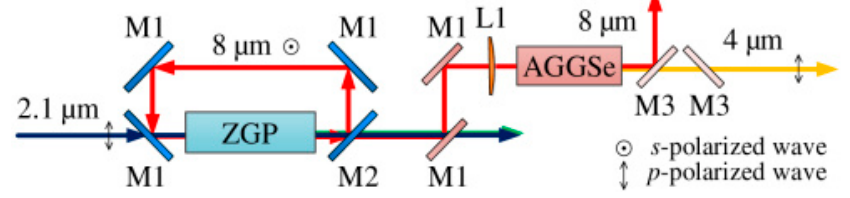
Figure 5. T he Experimental setup of AGGSe SHG [12]. Figure 5. The Experimental setup of AGGSe SHG